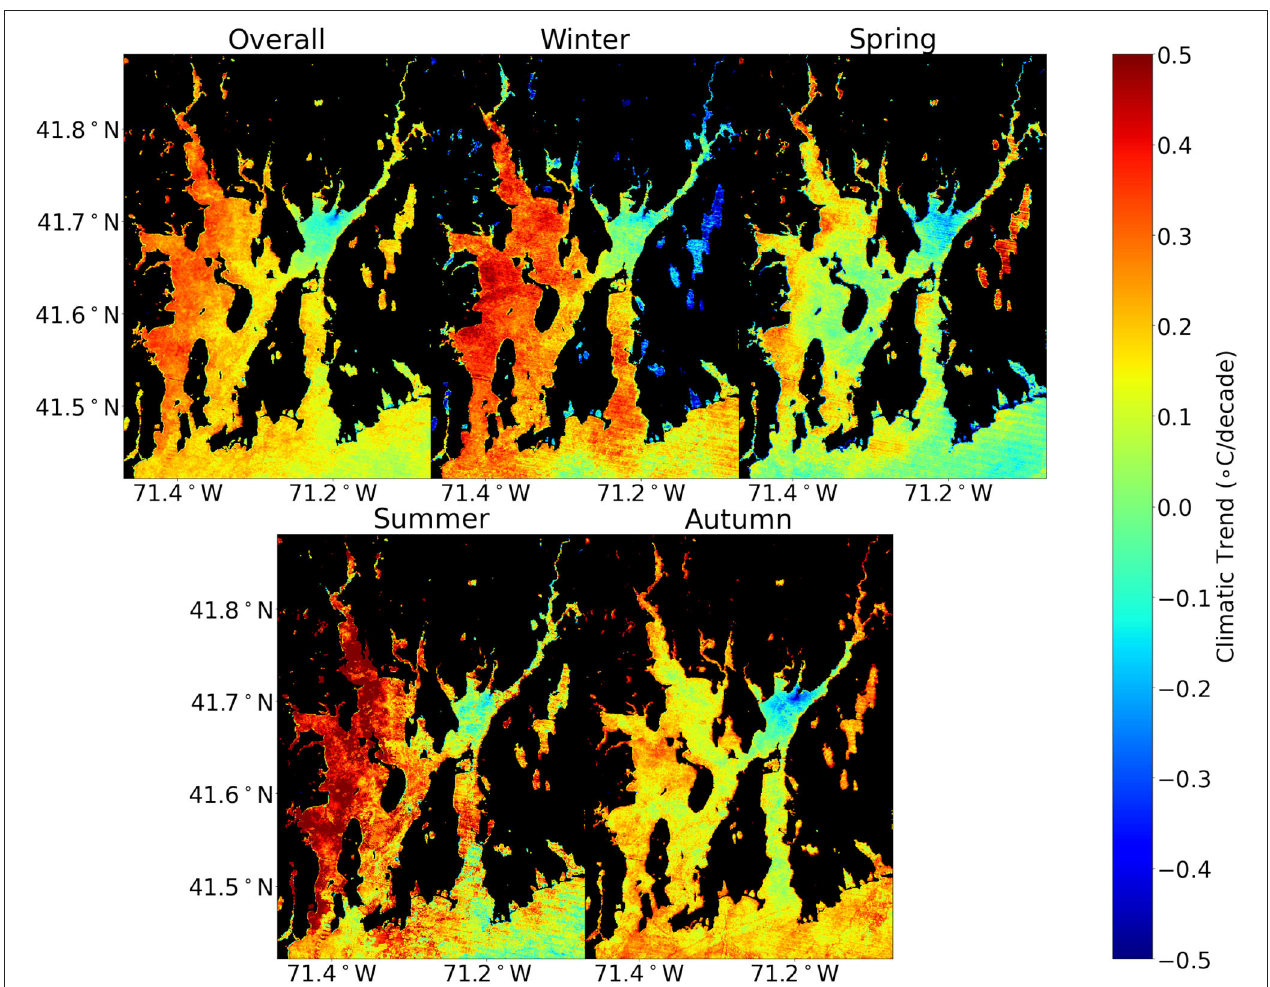
FIGURE 9 | Pixel-wise surface temperature trends for 1984–2021 using linear regression on seasonally-detrended Landsat thermal data. Data were filtered by month before interpolation to divide the trends by season.